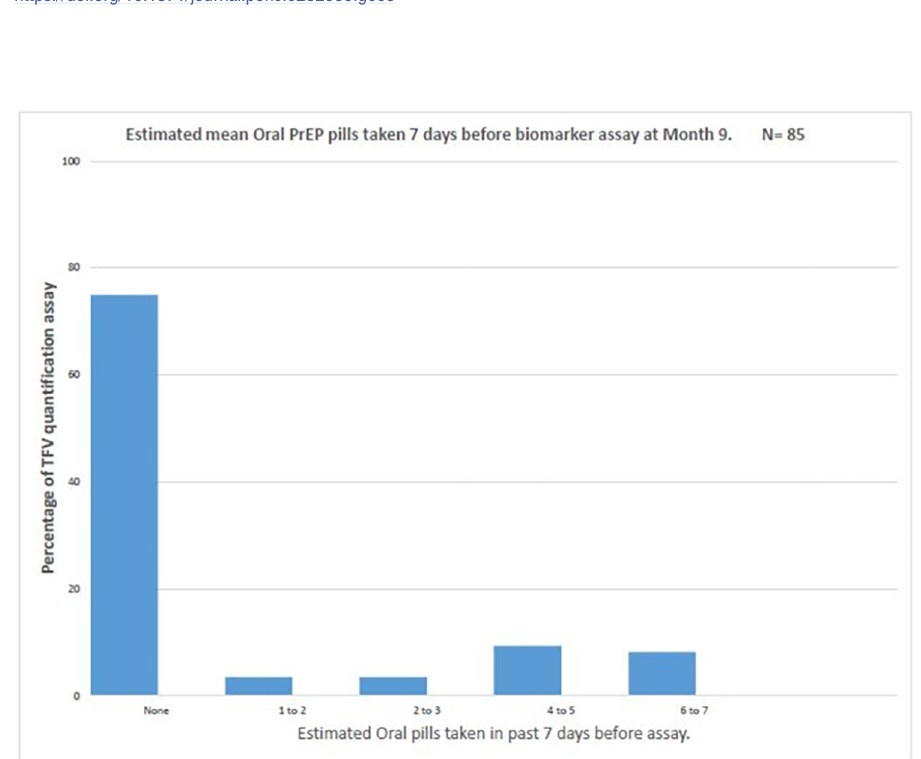
Fig 6. Estimated mean oral PrEP pills used a week before assay at Month 9.